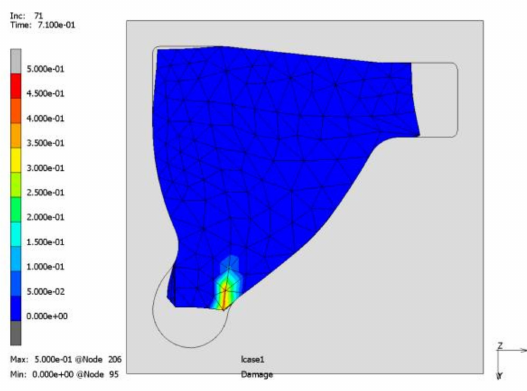
Figure 15. Forming process using tetraeder elements: joining zone damage.